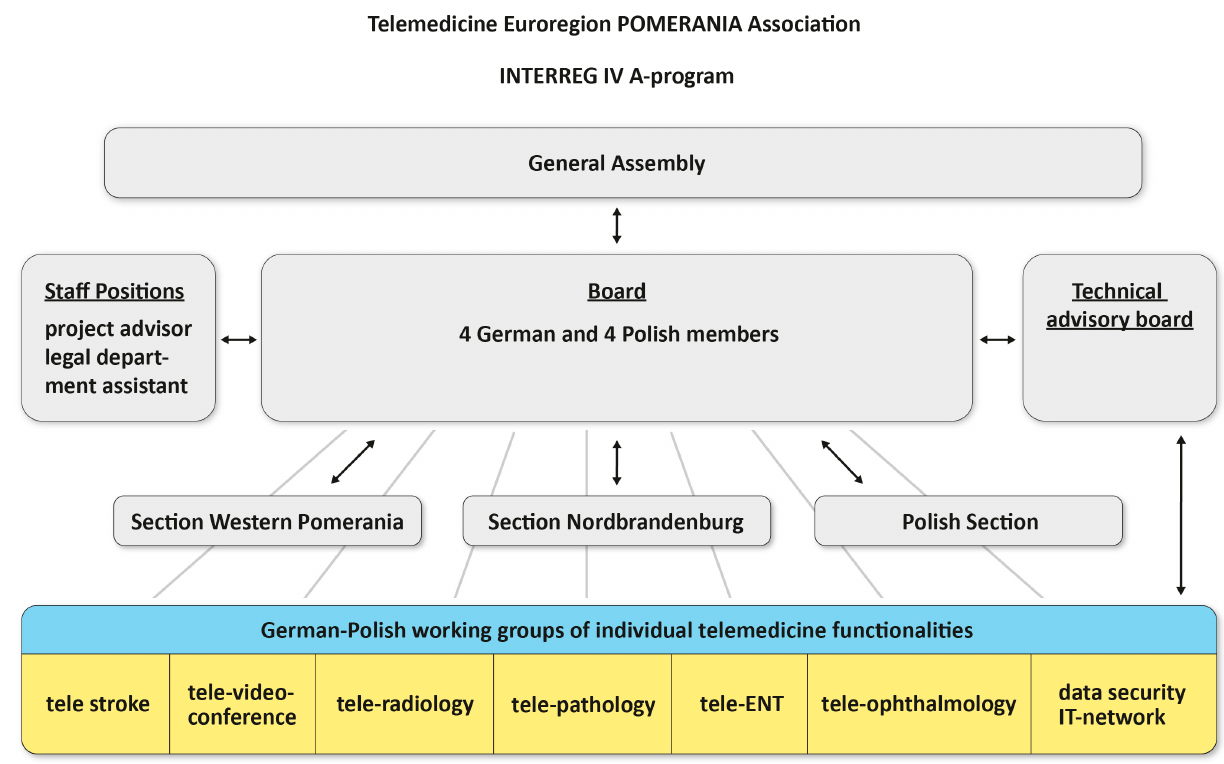
Figure 2. Organigram of the association “Telemedicine Euroregion Pomerania”. The German project participants organised themselves in an association under German law; three Polish members were co-opted. Their assembly (one representative with voting rights from each of the participating hospitals) approved key decisions and the budget once a year. The assembly elected the association’s board. Additional Polish members took part in German–Polish working groups. The German side was the lead partner of the project. It organised the settlement of the funds. The board of directors had several employees for legal, financial and secretarial tasks. A technical advisory board staffed with independent technical experts met twice a year for three years to review the investments.